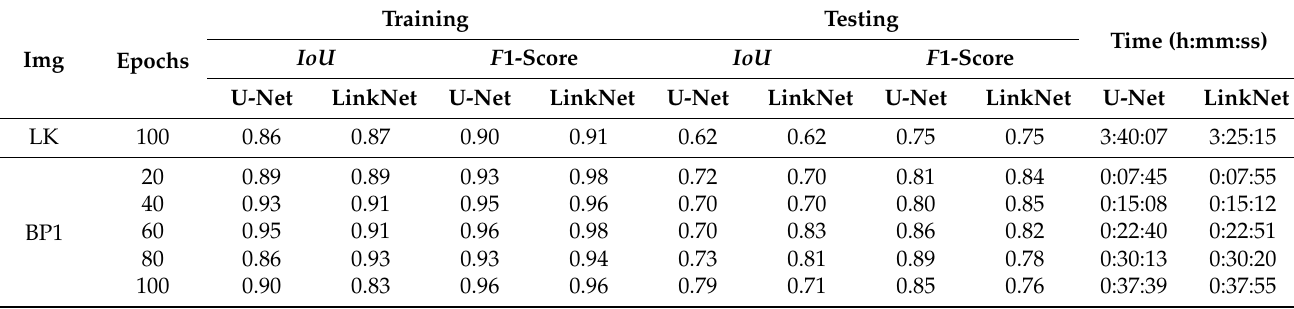
Table 3. Experiment # 2 results showing the training and testing accuracy (both mean IoU and F 1-score) and the time taken by the Lake Neshonoc models and the Brice Prairie subsets with different epoch